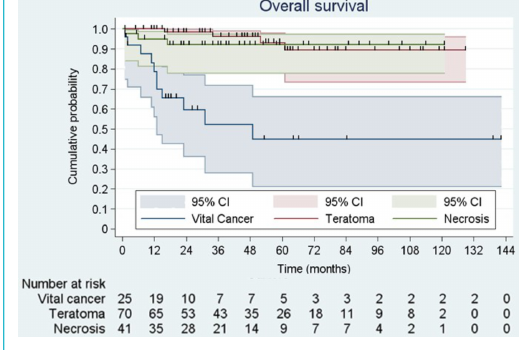
Figure 5: Kaplan-Meier analysis of overall survival after stratifica- tion for histology in the resected specimen. Vital cancer overall survival at 5 years 45% (95% CI: 21–66%); teratoma overall sur- vival at 5 years 90% (95% CI: 73–96%); necrosis overall survival at 5 years 93% (95% CI: 78–97%); p <0.001 for difference be- tween teratoma or necrosis and vital